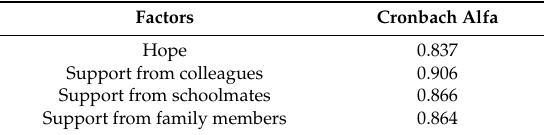
Table 4. Reliability analysis of expressions based on factors.